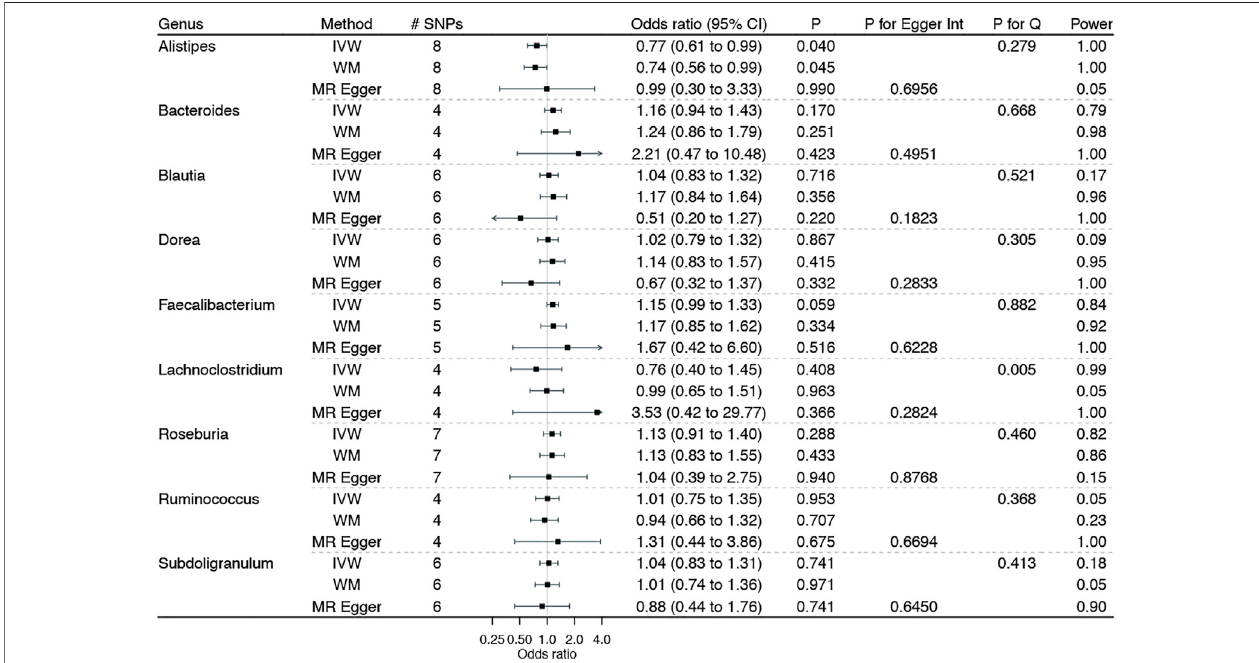
FIGURE1| AssociationsofgeneticallypredictedgeneraofgutmicrobiotaonBarrett ’ sesophagususingMendelianrandomization.IVW:inversevarianceweighted method with multiplicative random-effects; WM: weighted median estimator.